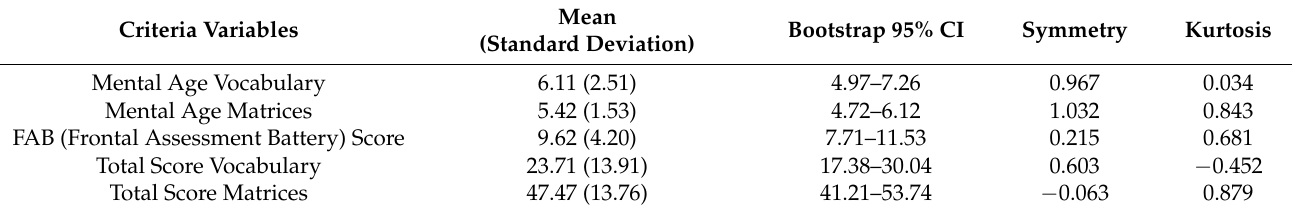
Table 3. Descriptions of the observed distributions of the criterion variables.